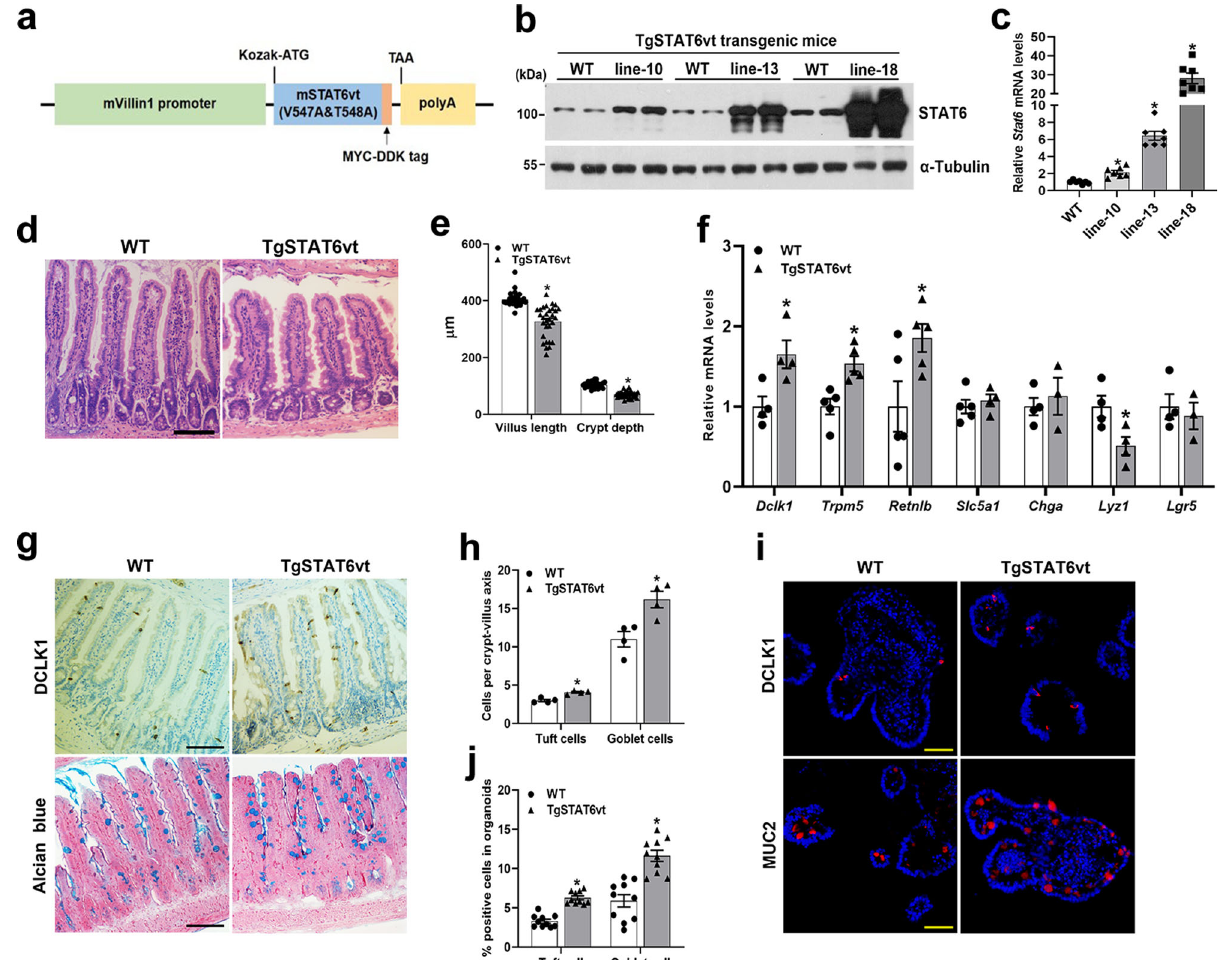
Fig.5|IEC-speci fi coverexpressionofconstitutivelyactivatedSTAT6(STAT6vt) promotes tuft and goblet cell differentiation. 2-month-old male WT and TgSTAT6vt mice (including line-10, line-13 and line-18) were subjected to the fol- lowing assays. a The strategy for creating TgSTAT6vt mice. b , c Western blot ( b ) and qPCR analyses ( c ) of TgSTAT6vt expression in the jejunal IECs. n =7 mice/ group in ( c ); p =0.0013 (line-10), <0.0001 (line-13), <0.0001 (line-18). d Representative H&E images of jejunum tissues. e Analyses ofjejunalvillus length andcryptdepth. n =30villiorcrypts/group; p <0.0001(villuslength,cryptdepth). f qPCRanalysisofIECmarkersexpressioninthejejunalIECs. Dclk1 , Lyz1 , n =4mice/ group; Trpm5 , Retnlb , n =5 mice/group; Slc5a1 , n =5 (WT) and 4 (Tg) mice; Chga , Lgr5 , n =4 (WT) and 3 (Tg) mice; p =0.0259 ( Dclk1 ), 0.0044 ( Trpm5 ), 0.0491